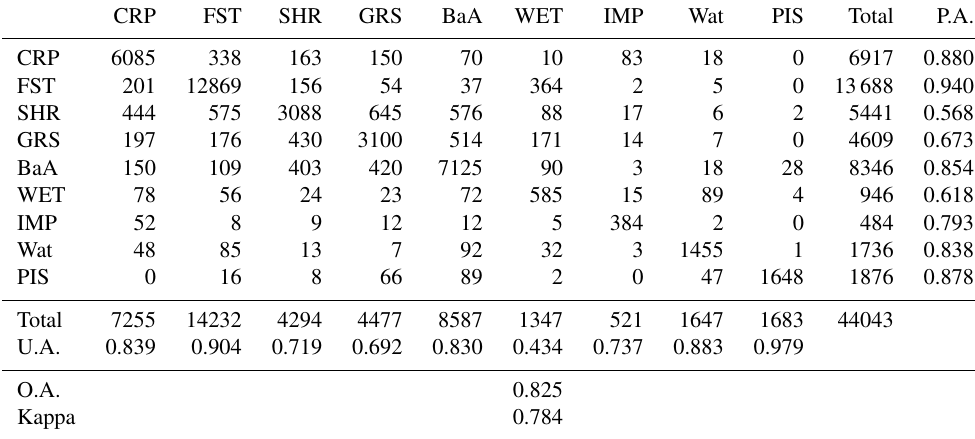
Table 3. The accuracy matrix for the GLC_FCS30-2015 land-cover product according to the level-0 validation scheme and containing nine major land-cover types.